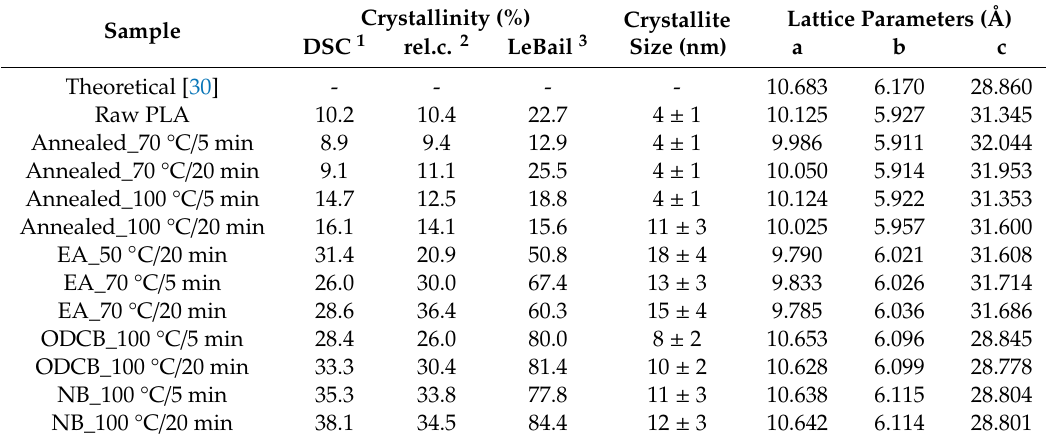
Table 5. Degree of crystallinity, crystallite size and lattice parameters calculated from XRD